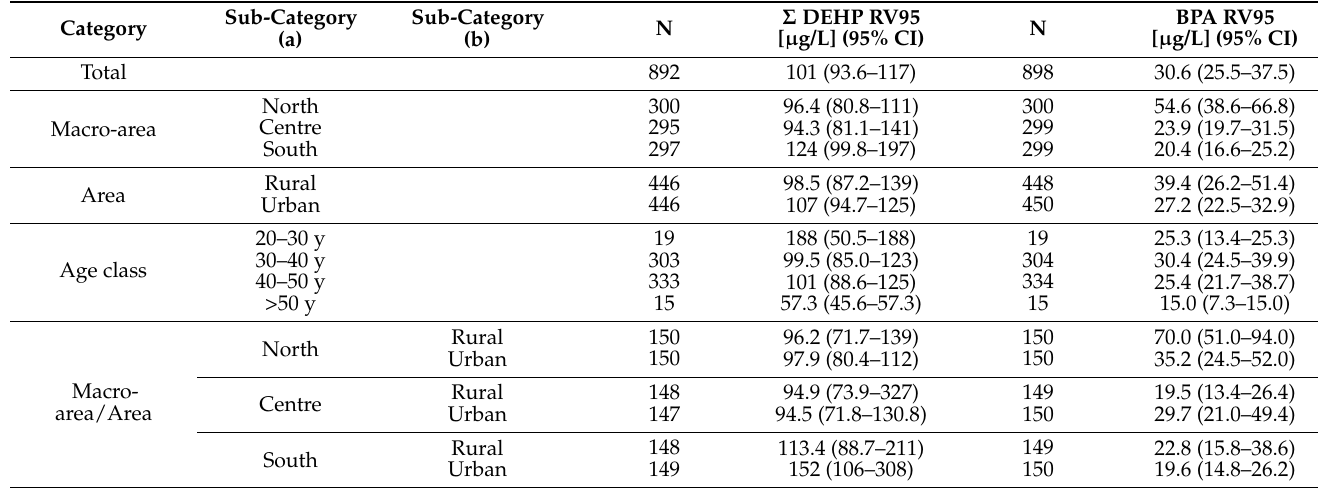
Table 8. Reference values (RV95, P95(95% CI)) for the sum of DEHP metabolites and BPA in urine of women according to the residing area/macro-area and to age